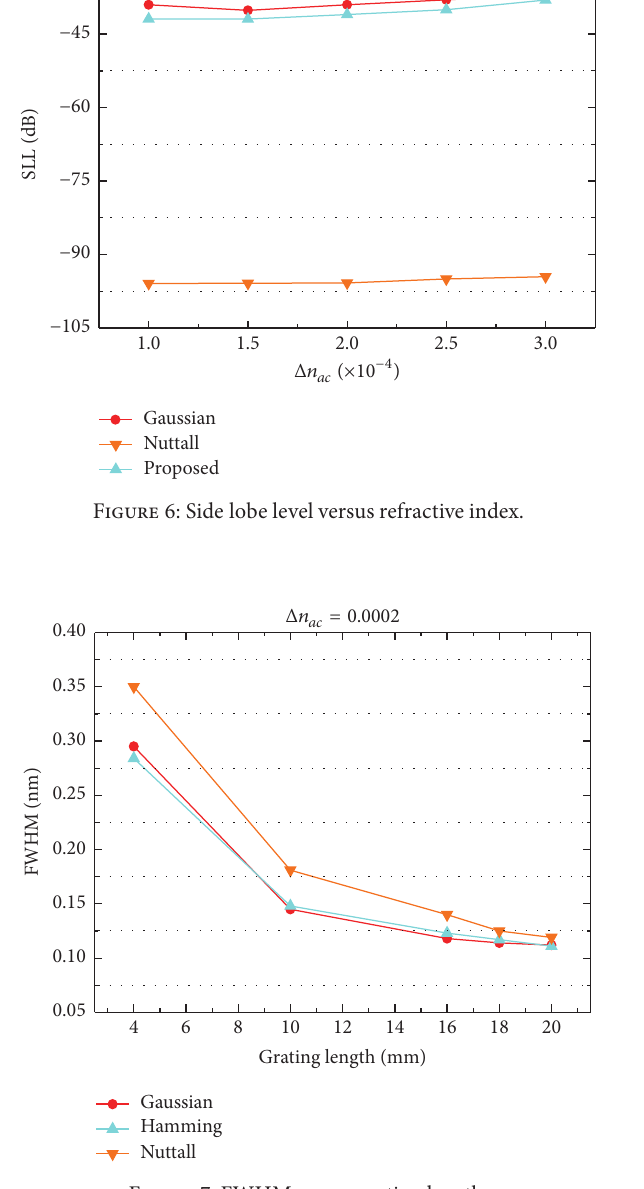
Figure 7: FWHM versus grating length.